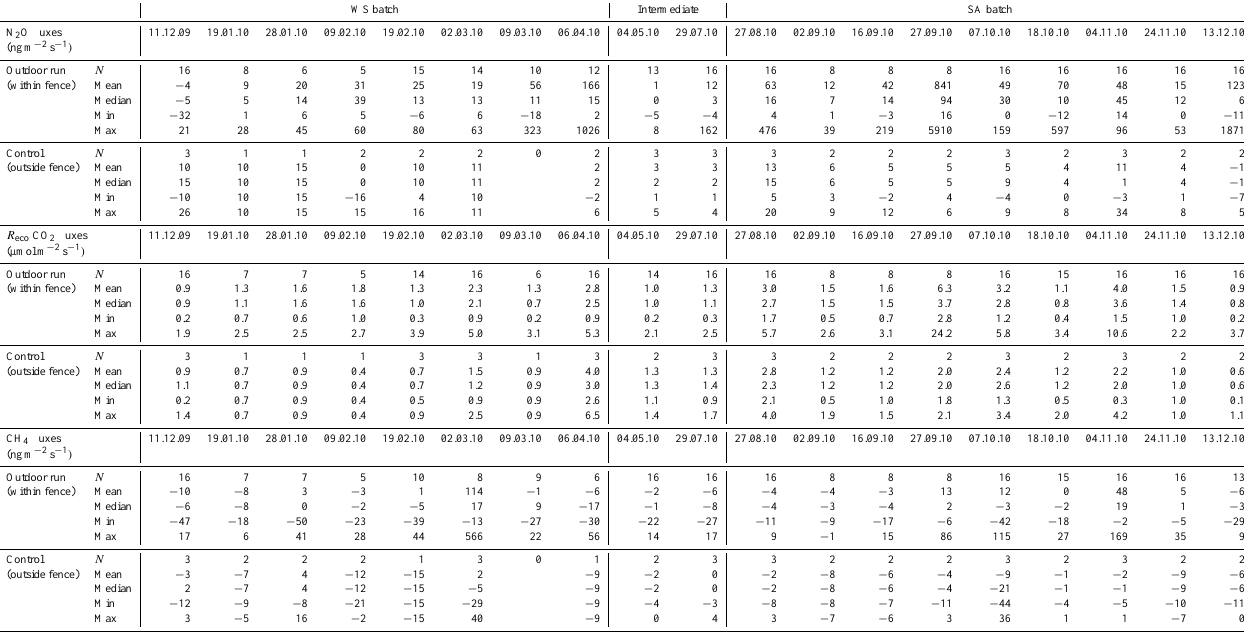
Table 2. Summary of N 2 O, CO 2 and CH 4 chamber flux statistics for each measurement date. WSbatch Intermediate SAbatch N 2